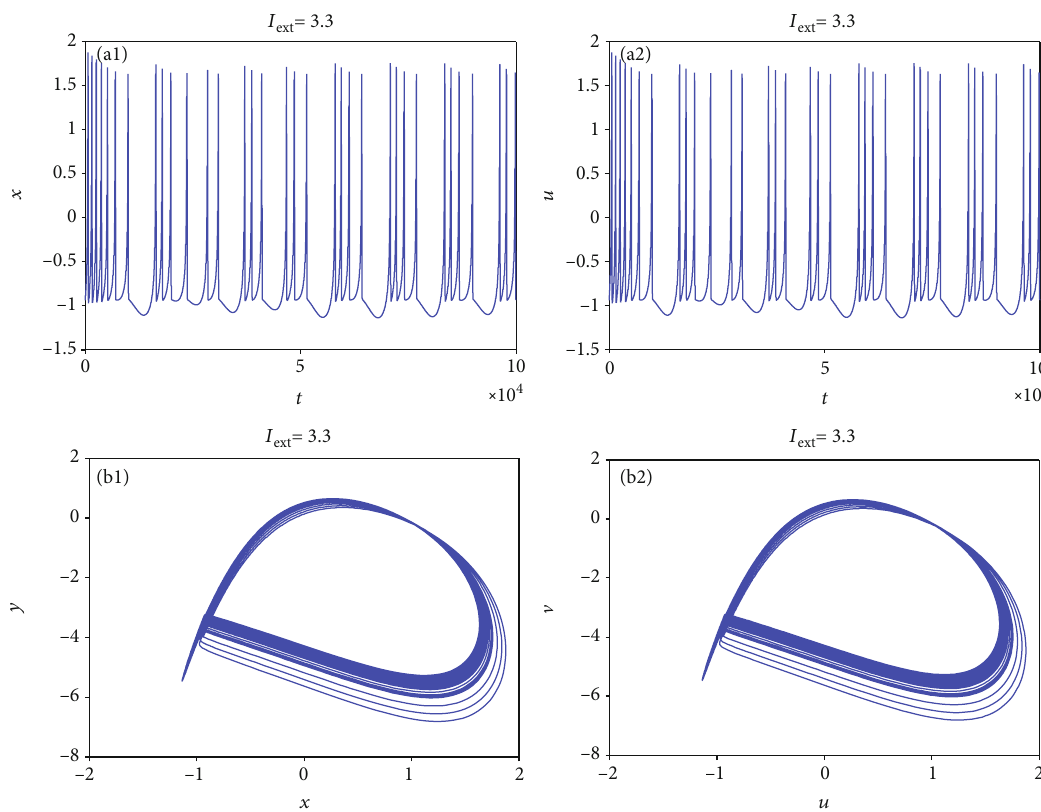
Figure 5: Chaotic fi ring pattern of model (2) when I Phase